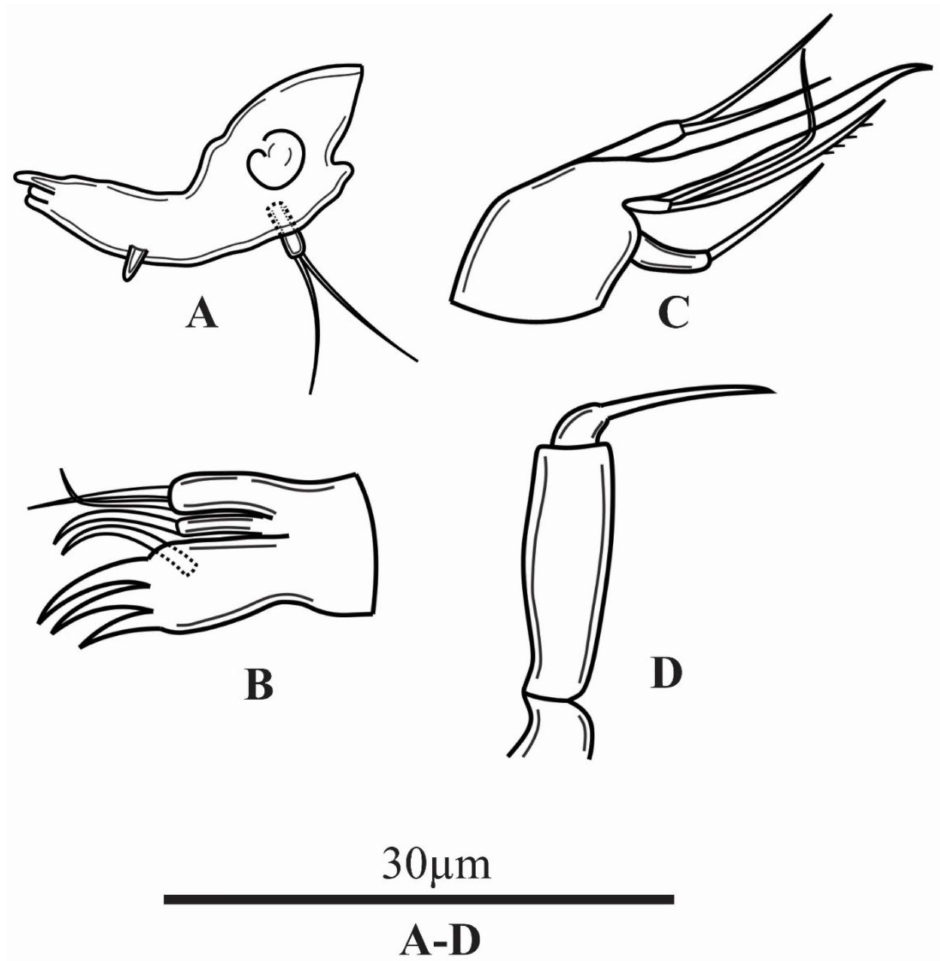
Figure 4. Parastenocaris sontraensis sp. nov. holotype female. ( A ), mandible; ( B ), maxillule; ( C ), max- illa; ( D ),